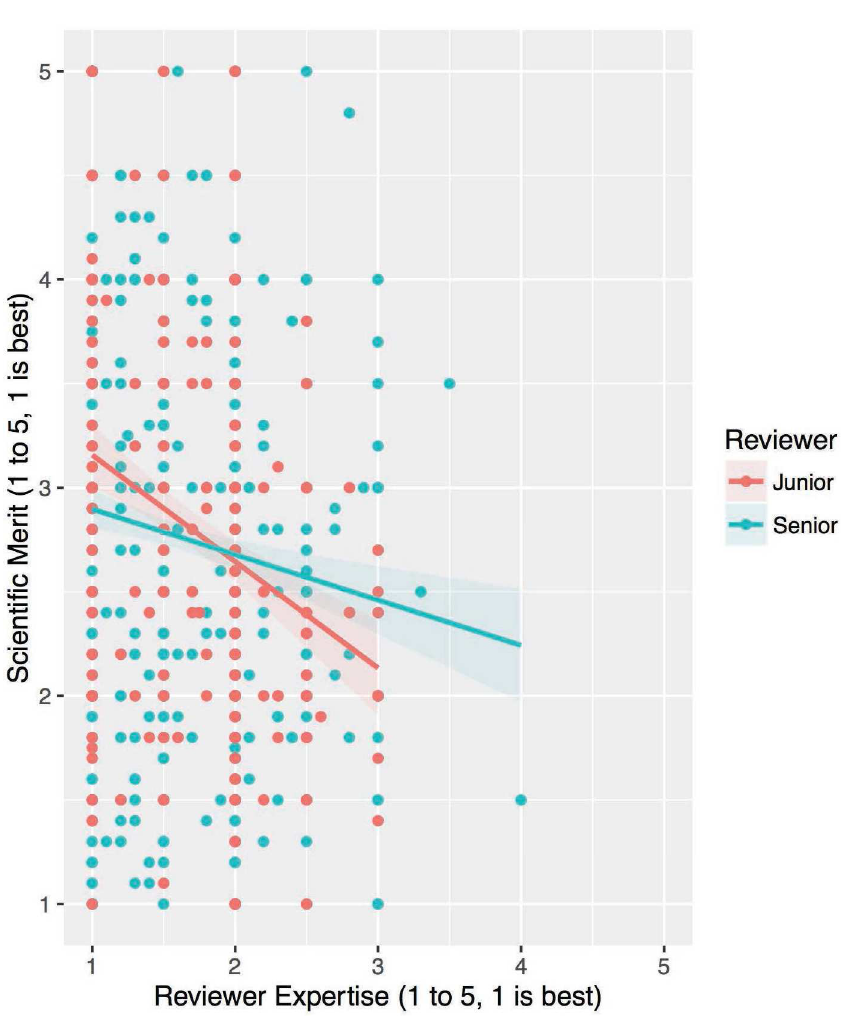
Fig 3. Reviewer Seniority Scatterplots of SM versus RE. Scatterplot and linear fit of raw SM versus RE scoring data of all evaluationsby junior reviewers (in red) and by senior reviewers (in blue). The shaded area represents 95% confidence